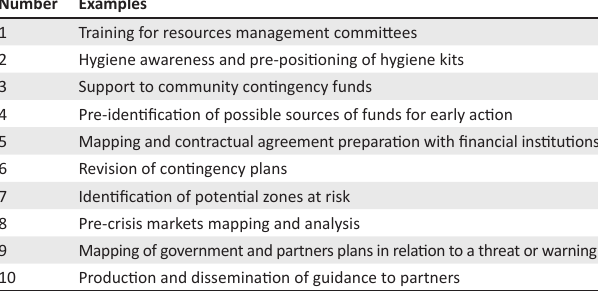
TABLE 1: Examples of activities agreed to be no-regrets